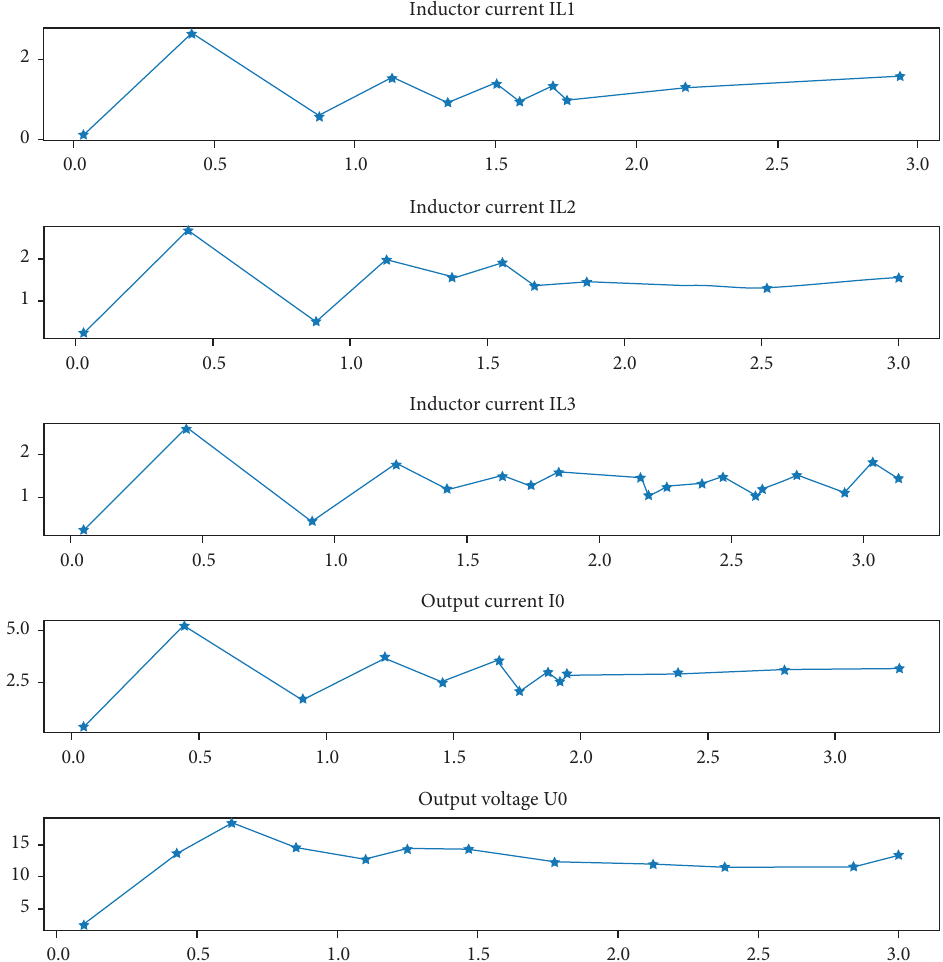
Figure 16: Simulation diagram of inductive current and output voltage current of each circuit.